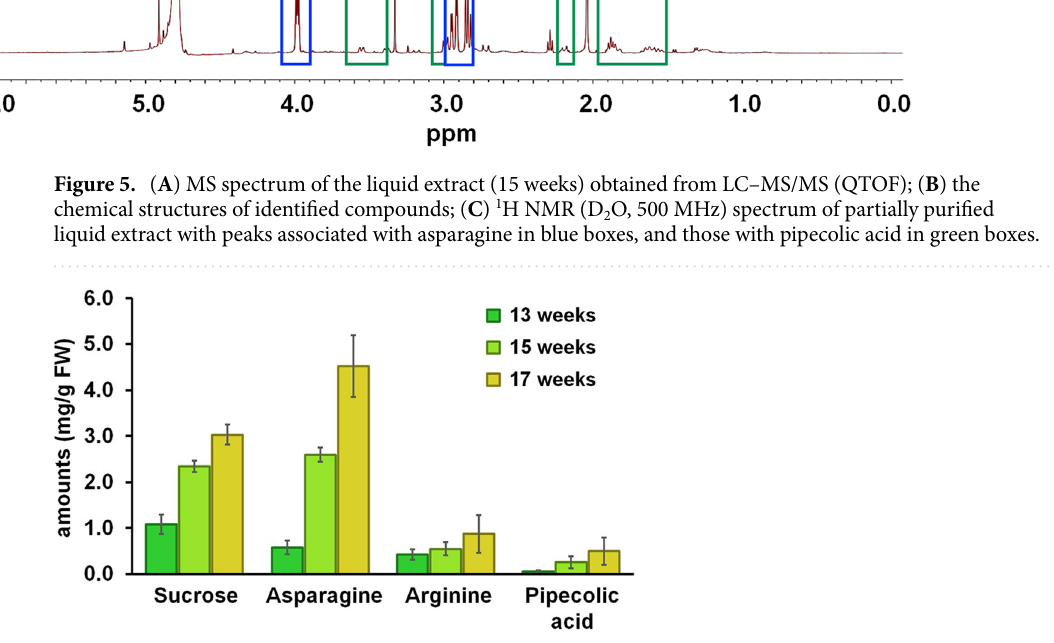
Figure 6. The amounts of sucrose, asparagine, arginine, and pipecolic acid in the peduncle of durian at different maturities (13, 15, and 17 weeks) as determined by LC–MS/MS